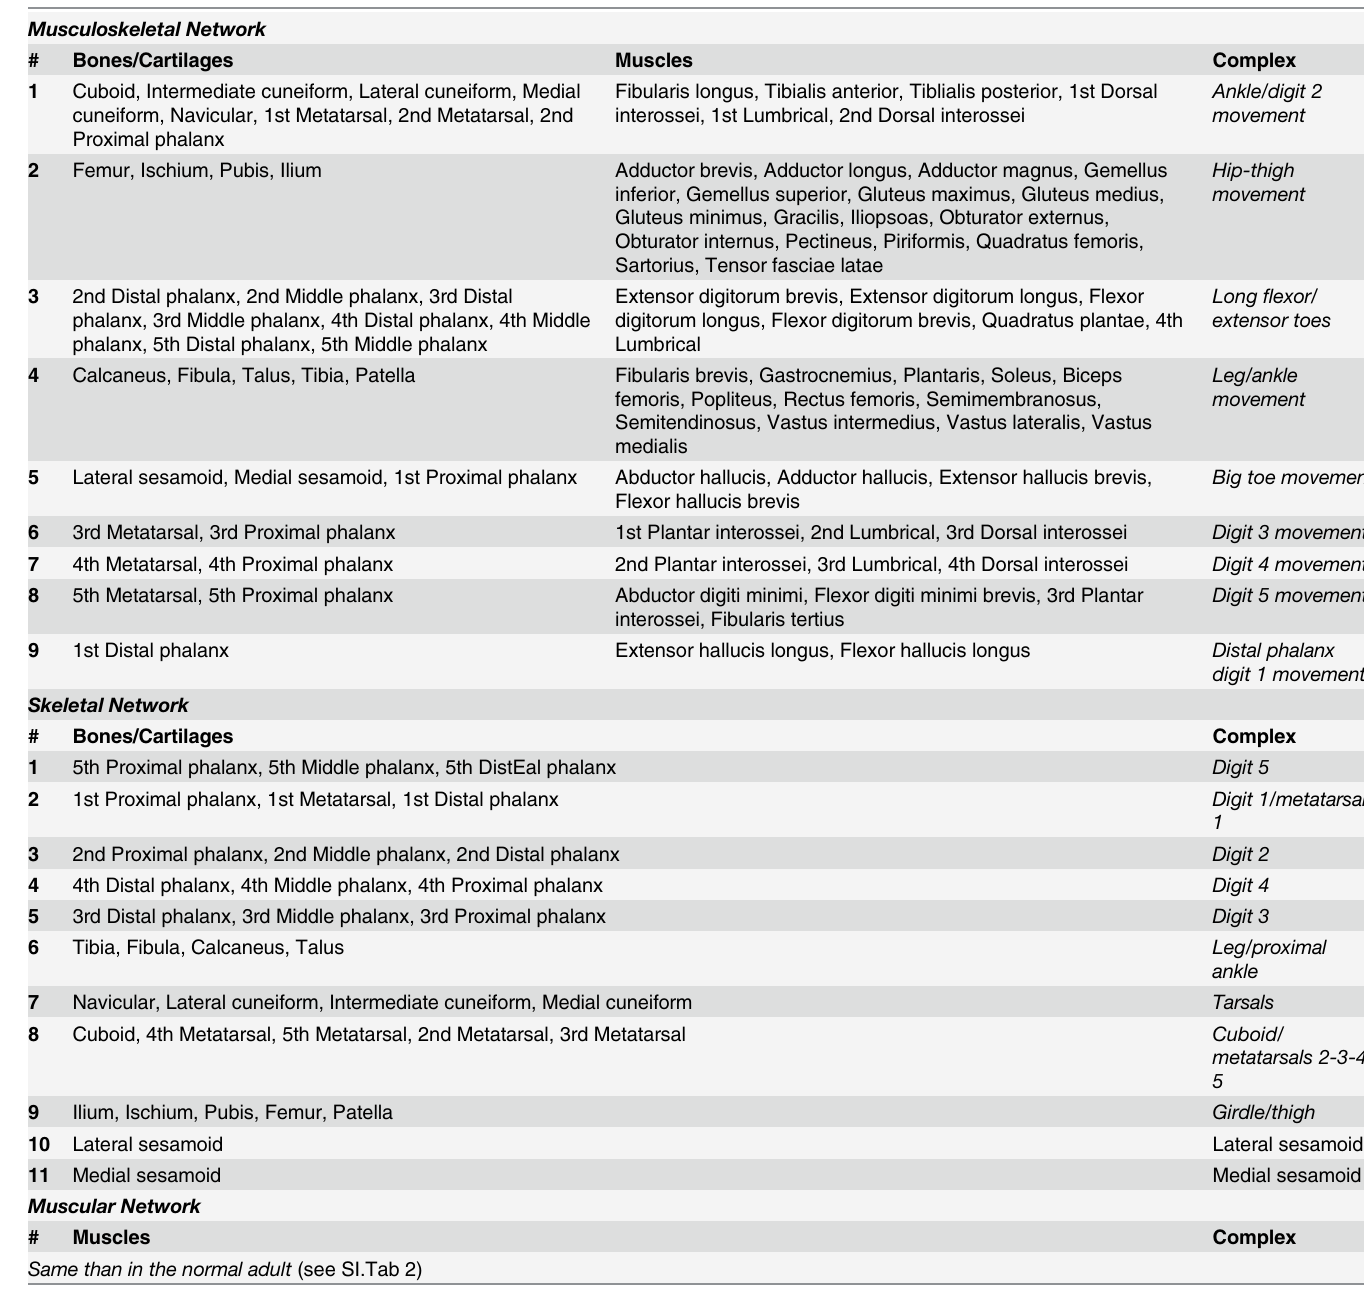
Table 3. Phenotypic modules in the lower limb of the normal